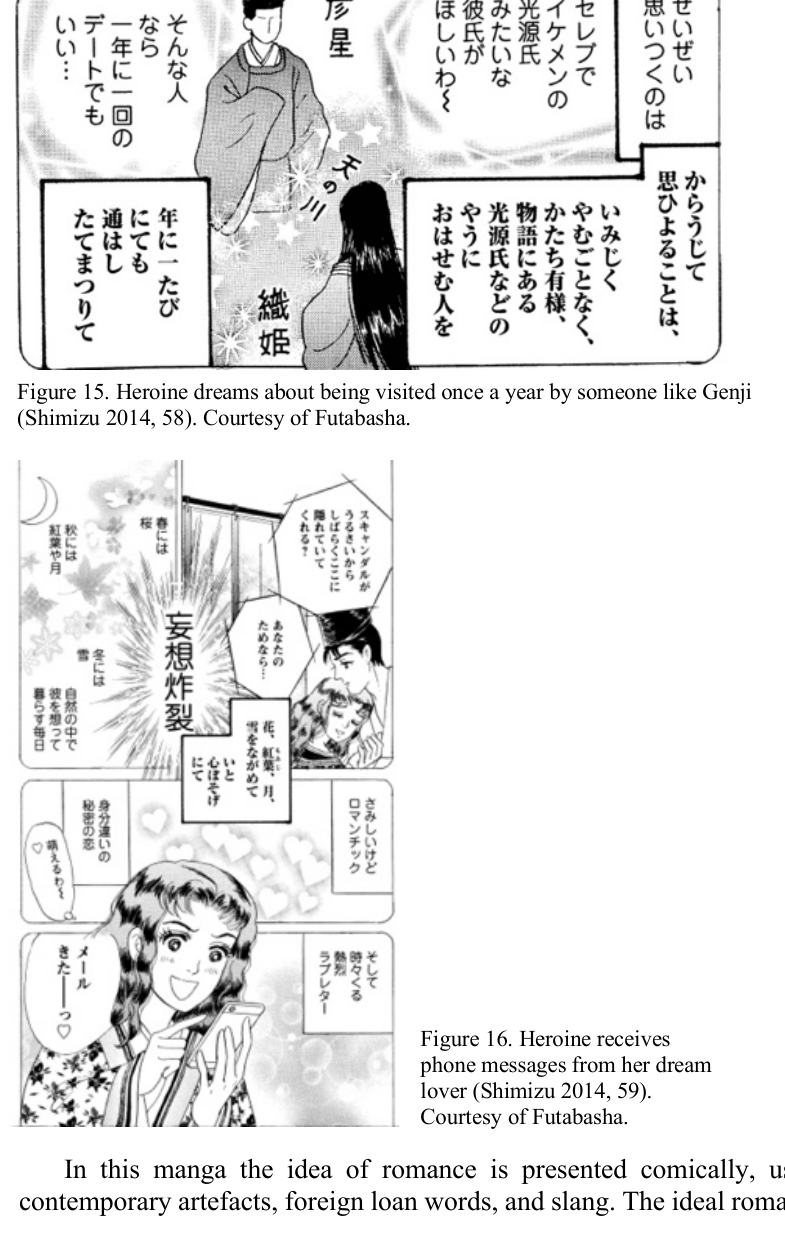
Japanese Language and Literature | jll.pitt.edu Vol. 55 | Number 1 | April 2021 | https://doi.org/10.5195/jll.2021.156